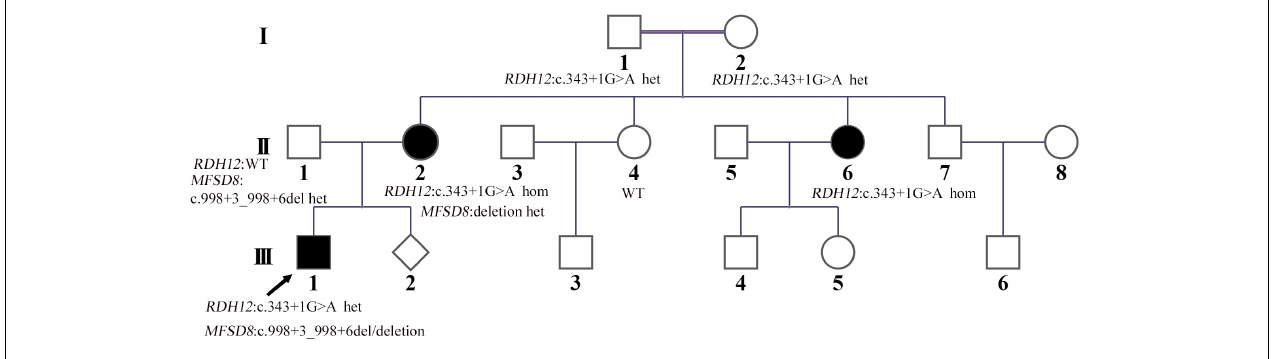
FIGURE 1 | Familial pedigree. The proband (III:1) is marked with an arrow. His disease courses started from visual loss at about three and a half years old. The mother of the proband (II:2) was from a consanguineous family; her and her older sister (II:6) developed symptoms of night blindness in the third decade of life, and the mother of the proband’s (II:2) condition of the fundus was the same as that of the proband. Only for the proband, seizures were observed as the second symptom after decreased vision from about 4 years